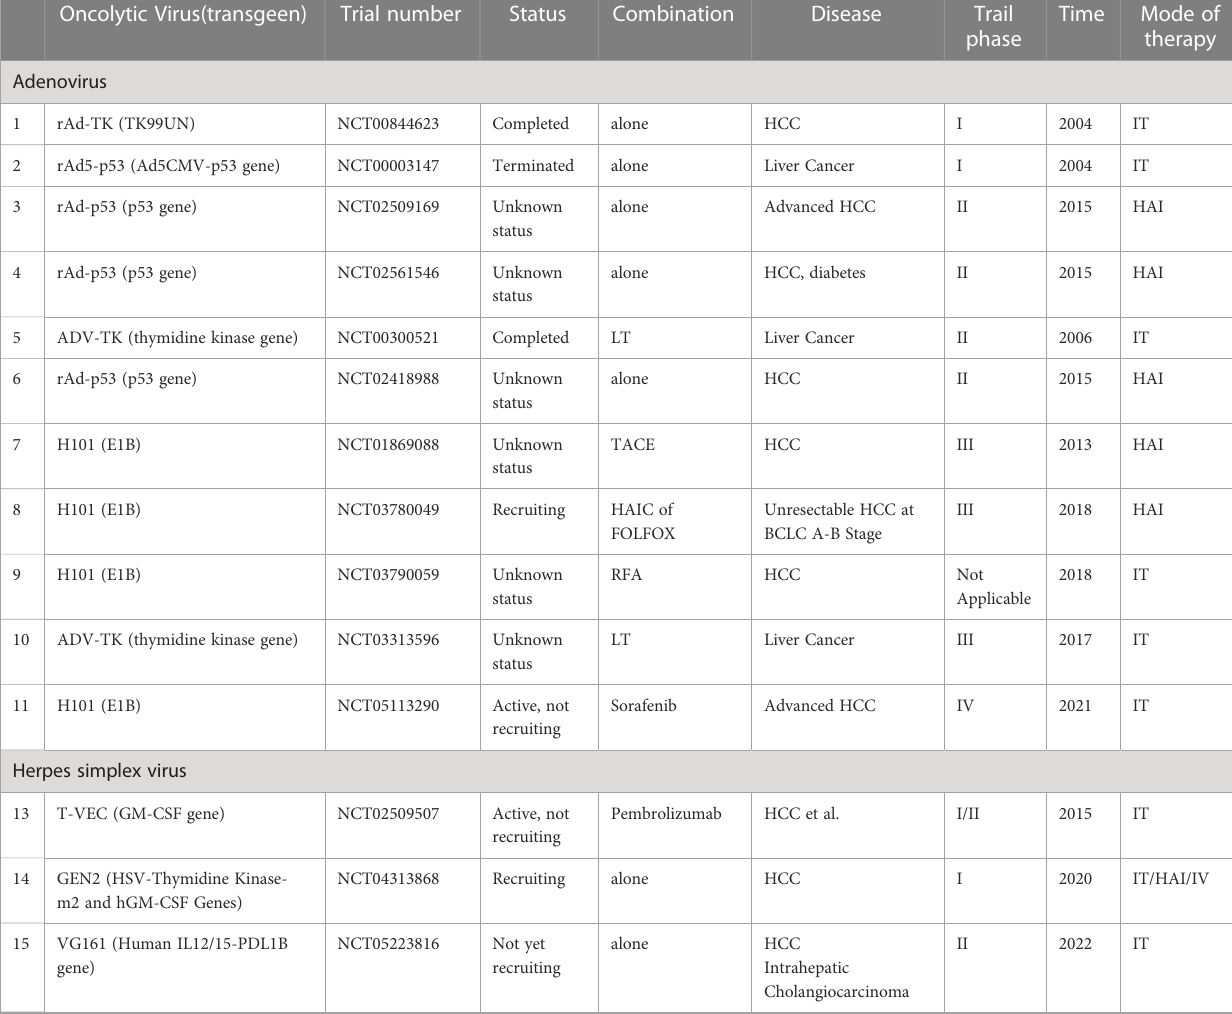
TABLE 1 Clinical trials of OVs for HCC since the 21 st century. Oncolytic